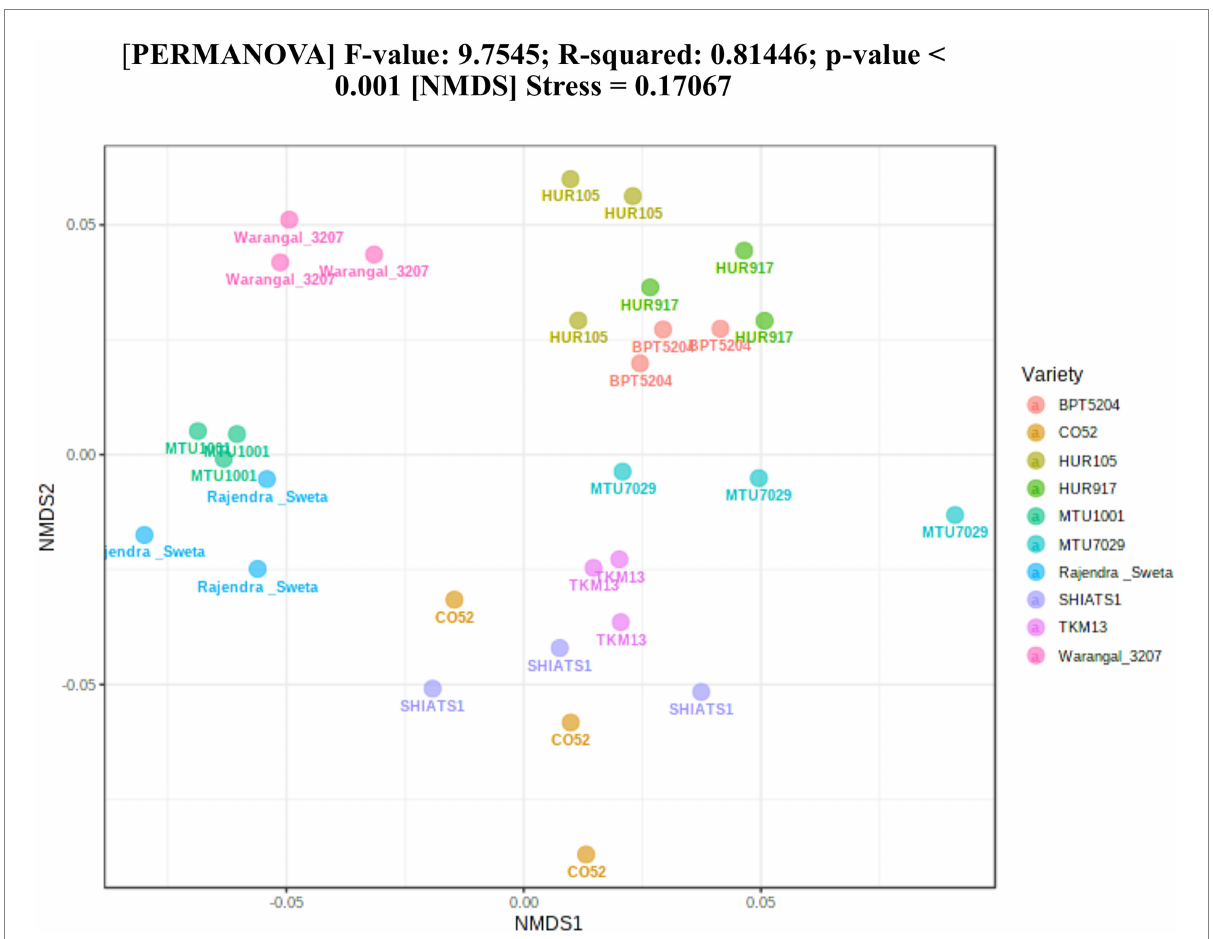
FIGURE 3 Estimation of rank based β -diversity based on NMDS-PERMANOVA to show statistical significance of the effect of rice varieties on the assemblage of rhizo-microbiome ( p <